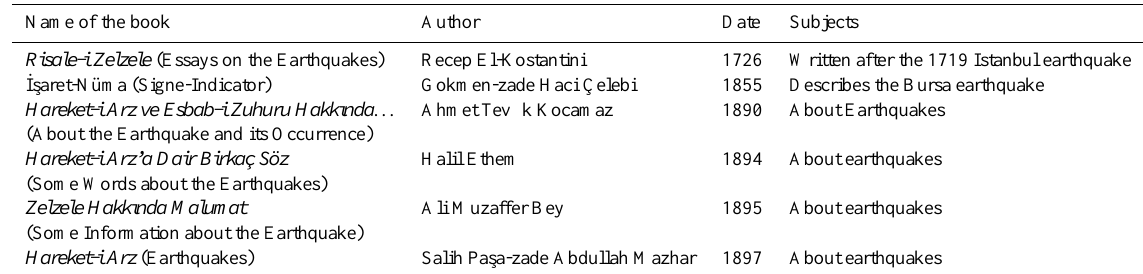
Table 2b. Some Turkish books about earthquakes between 1800 and 1900 (˙Izgi,